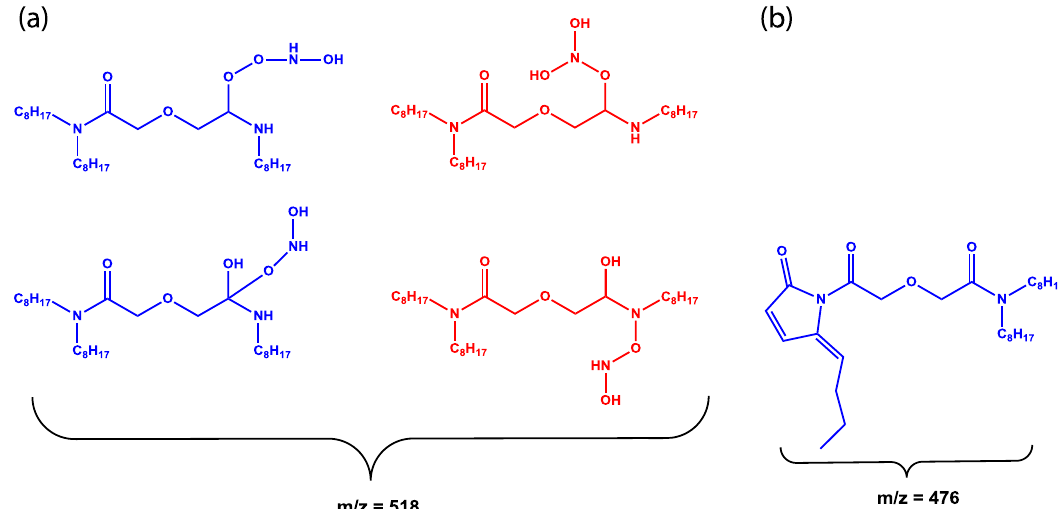
Fig. 5. Hypothetical structure of new possible TODGA degradation compounds corresponding to (a) m/z 518 and (b) m/z